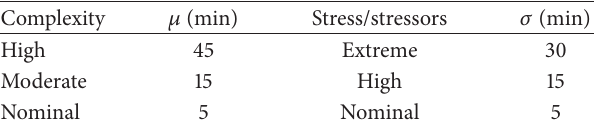
Table 2: Correspondence table between complexity and stress/ stressor level and time